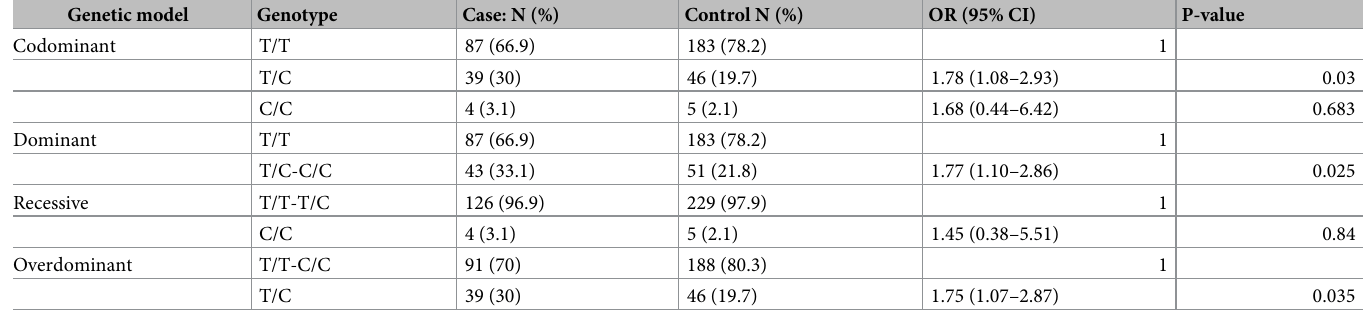
Table 4. Testing the association between risk of HL and SNP rs5743836 by finding odds ratio (OR) for different genetic models with confidence interval (CI) of 95%. Genetic